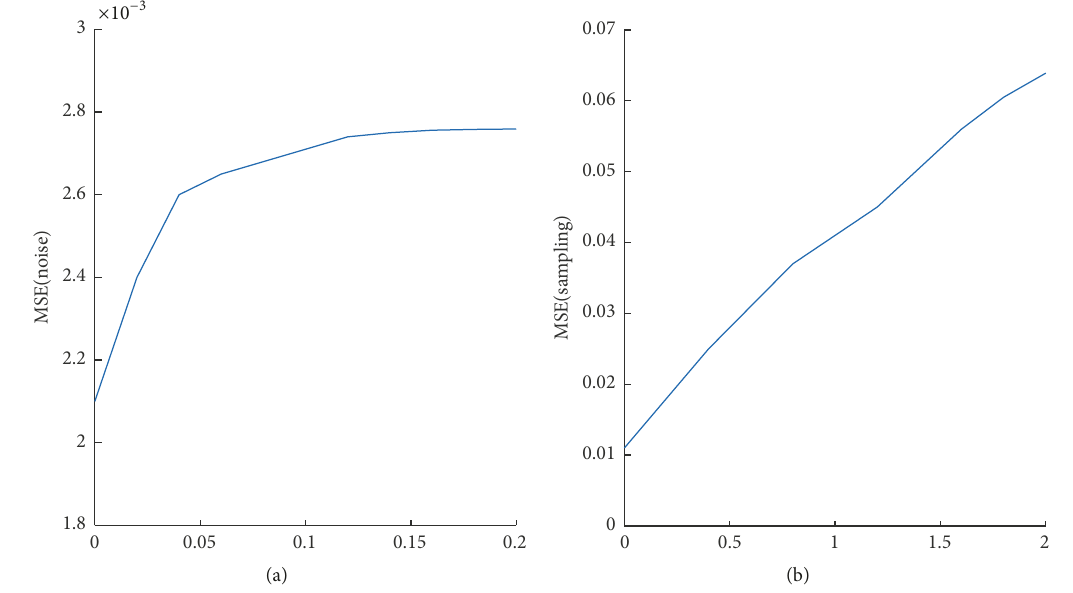
Figure 8: Evaluation of the noise (a) and sampling process (b) over the estimation